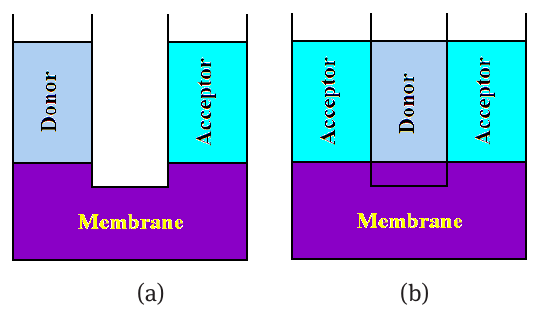
Figure 6: Bulk liquid membrane system: (a) a downward U-shaped tube, (b) a hollow tube inserted in a vessel.